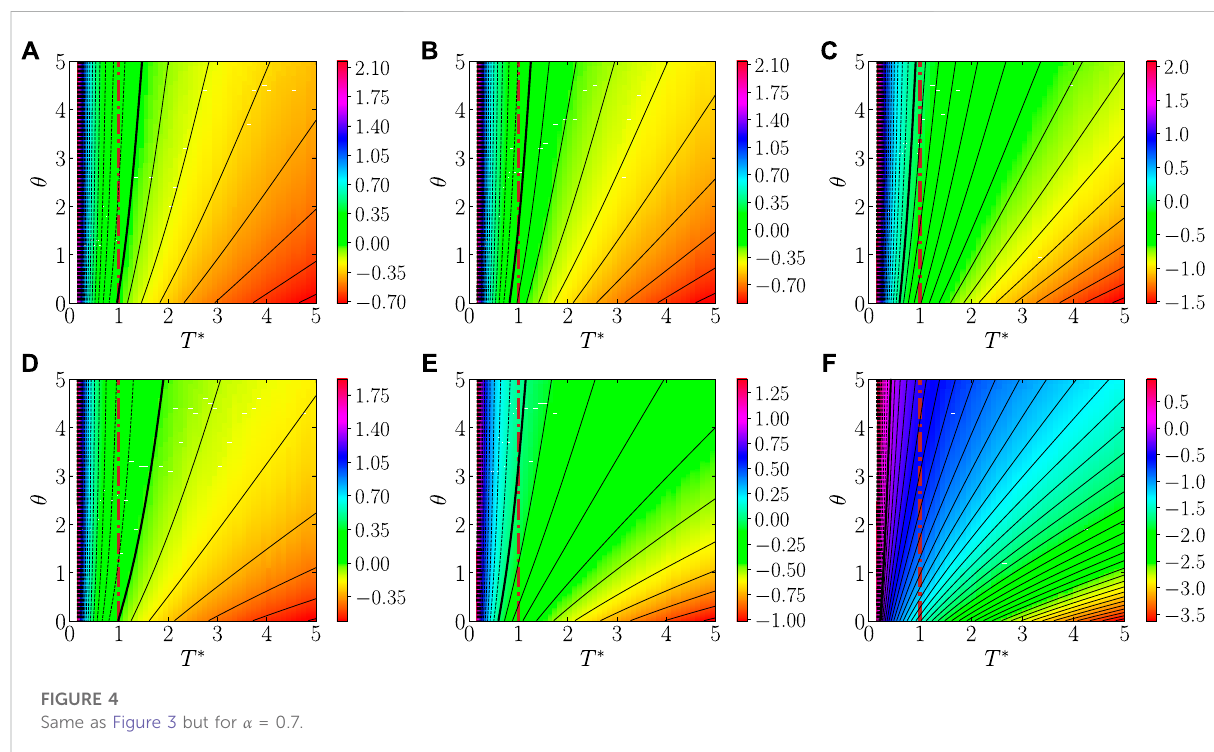
, θ ) splits the plane ε vs. T p 0 0